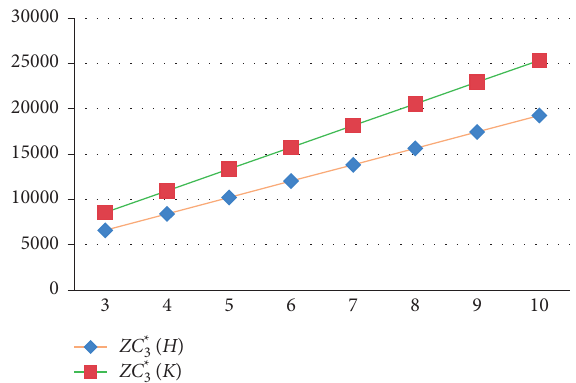
Figure 7: Comparison of ZC ∗ dimensions 3 ≤ n ≤ 10.